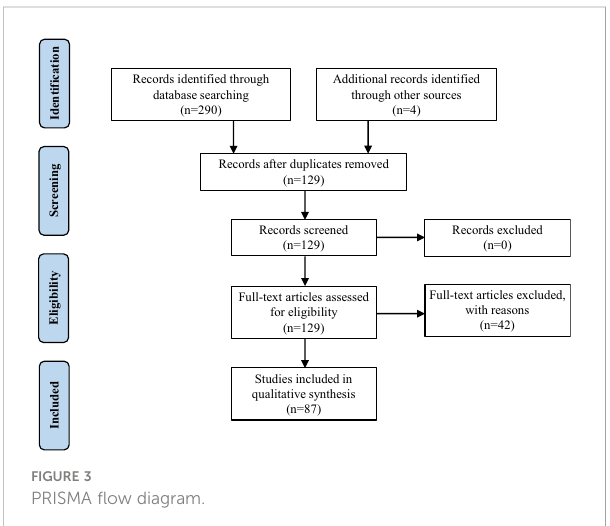
FIGURE 3 PRISMA fl ow